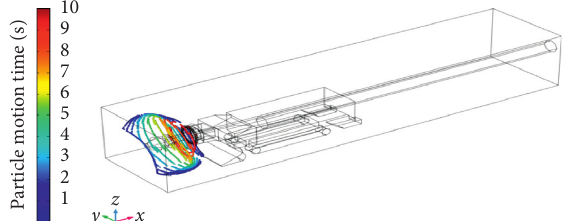
Figure 13: Particle trajectory with an air volume of 1.5m 3 /min.